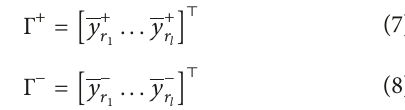
where 𝑠 𝑖 is the 𝑖 ’th species , 𝑦 𝑗 is the 𝑗 ’th complex , and 𝑟 V is the V ’th reaction of the network. Moreover, 𝛼 𝑗𝑖 is the stoichiometric coefficient of the 𝑖 ’th species in the 𝑗 ’th complex. 󳨀→ 𝑦 R , 𝑦 For a reaction 𝑟 V = 𝑦 𝑠𝑜𝑢𝑟𝑐𝑒(𝑟 𝑝𝑟𝑜𝑑𝑢𝑐𝑡(𝑟 V ) of 𝑠𝑜𝑢𝑟𝑐𝑒(𝑟 V ) V ) and 𝑦 𝑝𝑟𝑜𝑑𝑢𝑐𝑡(𝑟 are the source complex and the product V ) complex,